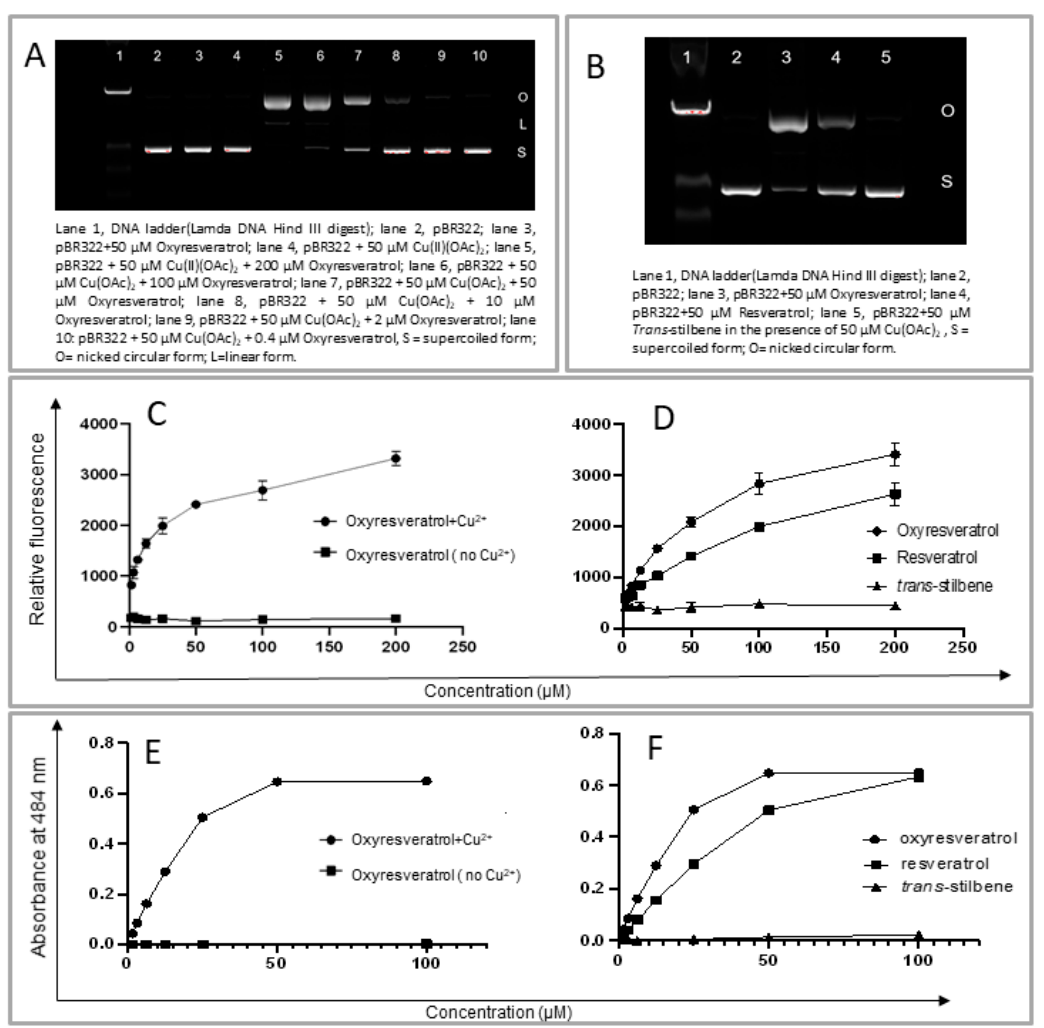
Figure 4. Effect of oxyresveratrol on DNA, ROS generation and copper reduction in cell-free assays. ( A ) DNA damage induced by oxyresveratrol at six concentrations of Cu(OAc) 2 . ( B ) Comparison of DNA damage induced by oxyresveratrol, resveratrol, and trans -stilbene. ( C ) Generation of ROS by oxyresveratrol in the presence or absence of Cu(II). ( D ) Comparison of generation of ROS by oxyresveratrol, resveratrol, and trans- stilbene. ( E ) Reduction of Cu(II) by oxyresveratrol. ( F ) Comparison of copper-reducing ability of the three stilbenoids. Values express mean ± SD (n = 3).